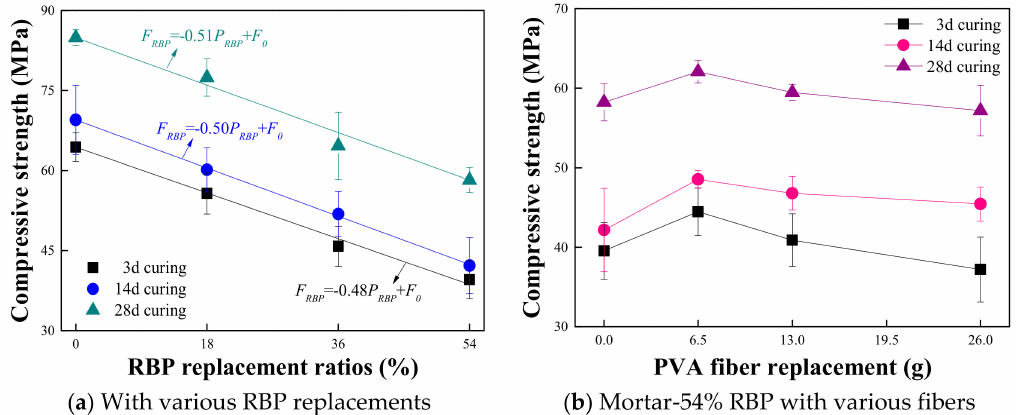
Figure 7. Compressive strength of mortar with vaious contents of RBP and PVA fiber. (Displayed values are the mean values of three measurements). ( a ) With various RBP replacements; ( b ) Mortar-54% RBP with various fibers.